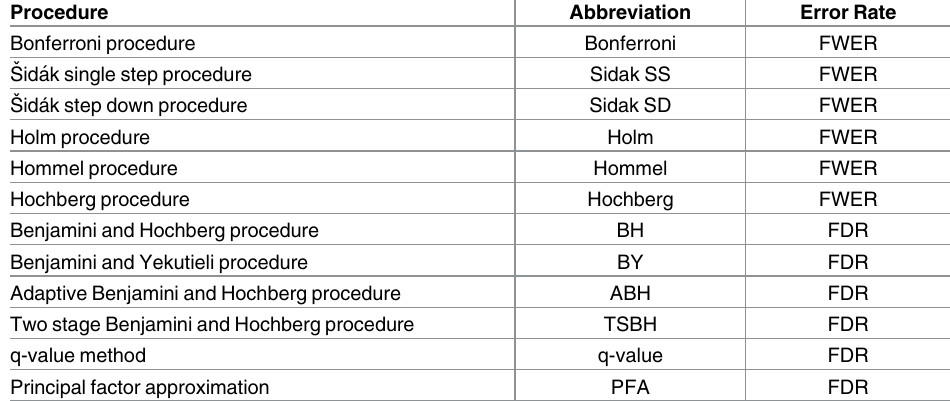
Table 1. Abbreviations of multiple comparison procedures (and their corresponding controlled error rate), used in the text and in summaryfigures.